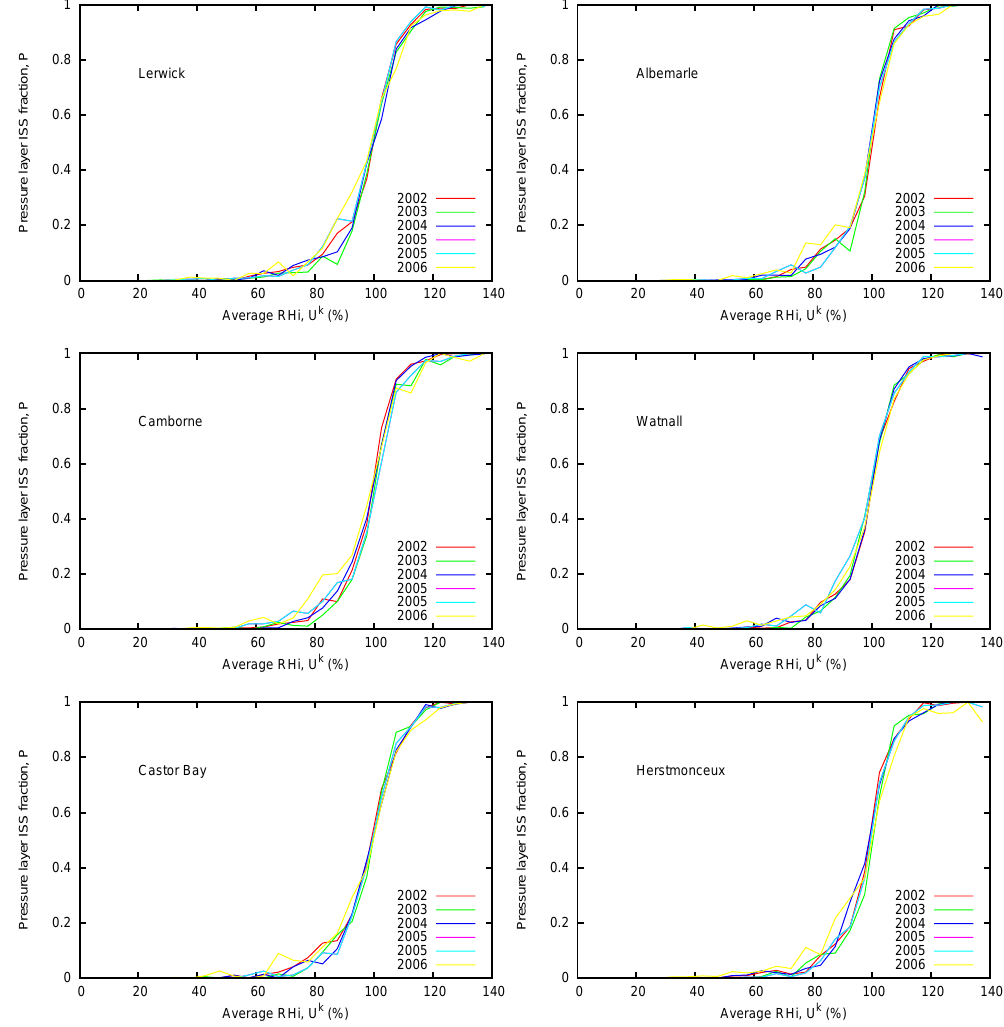
Fig. 6. The relationship between average RHi and the ISS fraction for the 250–300hPa pressure layer is shown. These curves are derived from individual calender years (January 2002–December 2006) of high resolution radiosonde launches from six launch stations within the Brisitsh Isles.